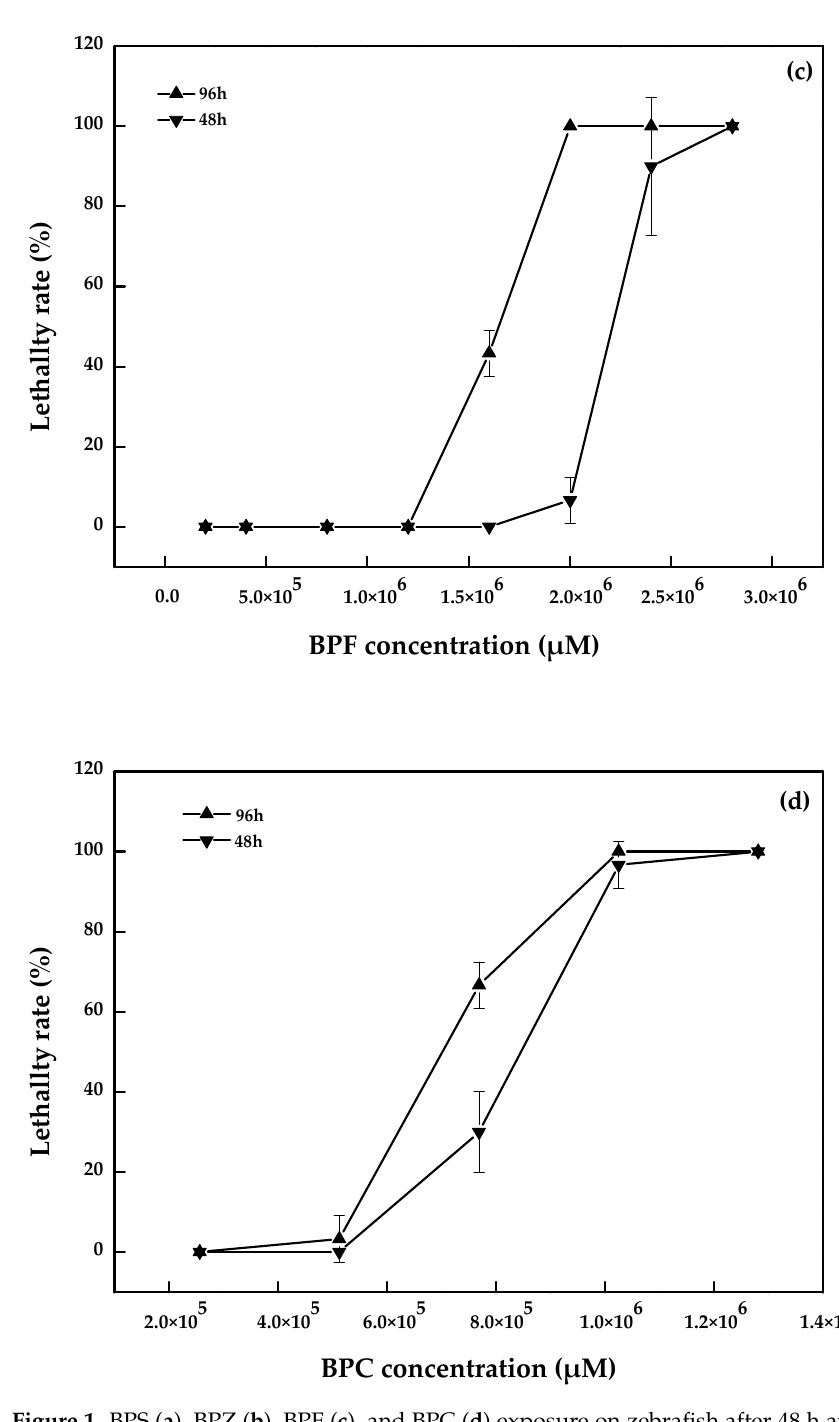
Figure 1. BPS ( a ), BPZ ( b ), BPF ( c ), and BPC ( d ) exposure on zebrafish after 48 h and 96 h (values represent mean ± S.D., sample size: 3).